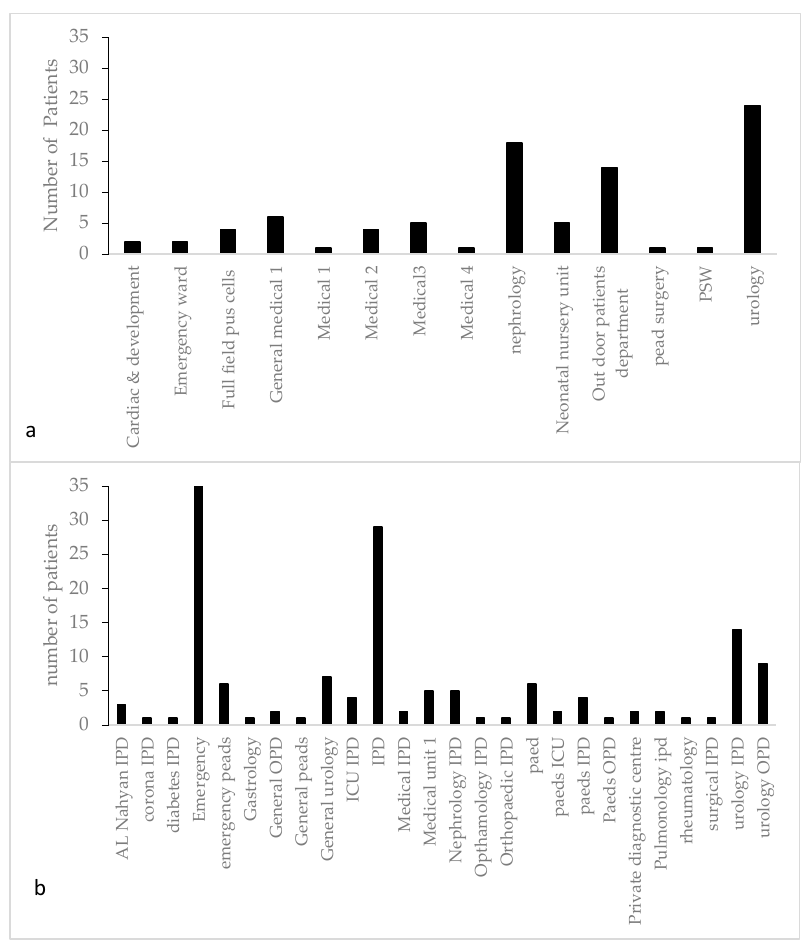
Figure 1. Ward-wise distribution of pediatric patients’ (aged 0–6 years) samples showing positive results for Escherichia and Klebsiella on CLED agar: ( a ) from Children Hospital; ( b ) from Shaikh Zayed Hospital.